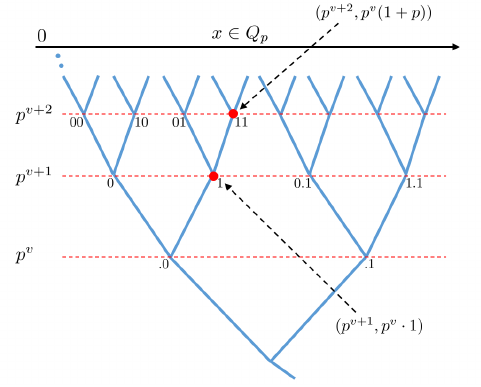
Figure 1. The coordinates on the BT